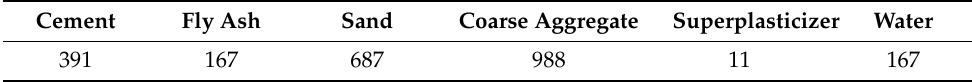
Figure 2. Powder particle size distribution and FA’s SEM image: ( a ) Powders’ particle size distribu- tion; ( b ) FA’s SEM image. Table 3. Mix Proportion of HSC with 30wt % FA (kg/m 3 ).